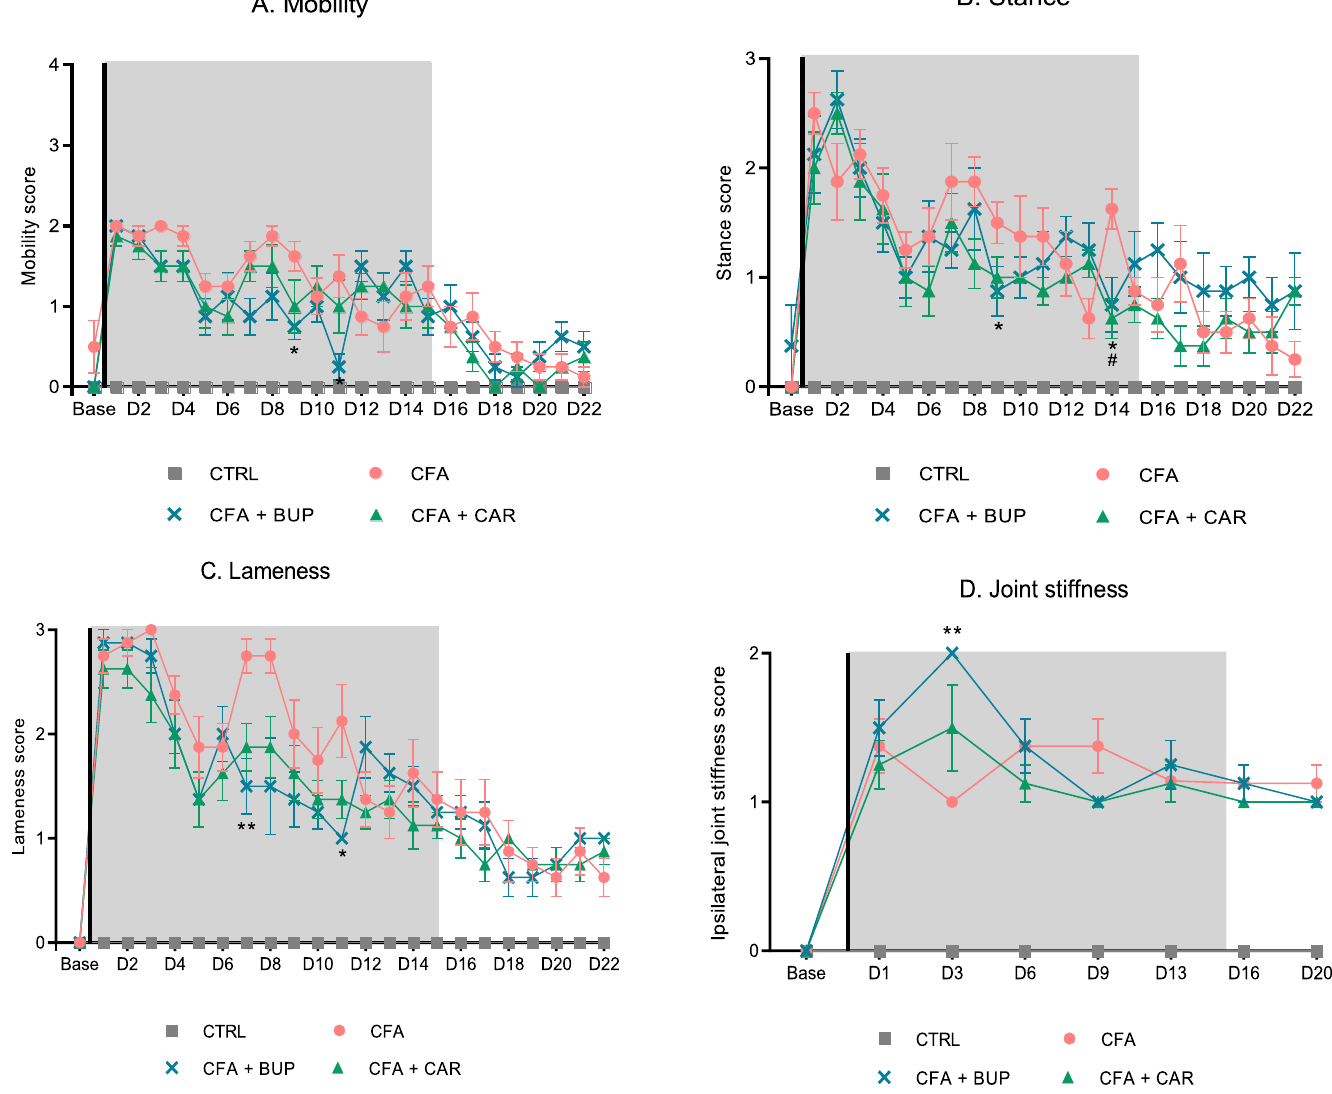
Fig 3. Model-specific parameters. (A) Mobility scores. (B) Stance scores. (C) Lameness scores. ( D) The joint stiffness score of the ipsilateral TTJ. Statistics are calculated on medians (Kruskal-Wallis test, followed by Dunn’s multiple comparisons test), but values are displayed as mean ± SEM for a better graphical view. The asterisk ( � ) represents statistically significant difference between CFA + BUP and CFA at � p < 0.05 and �� p < 0.01. The hash sign ( # ) represents a statistically significant difference between CFA + CAR and CFA at # p < 0.05. For all graphs: base = baseline values, D = day, the line represents the day of analgesic treatment initiation (D0) and the grey area represents the treatment period (15 days). All groups, n = 8, male Sprague Dawley rats.